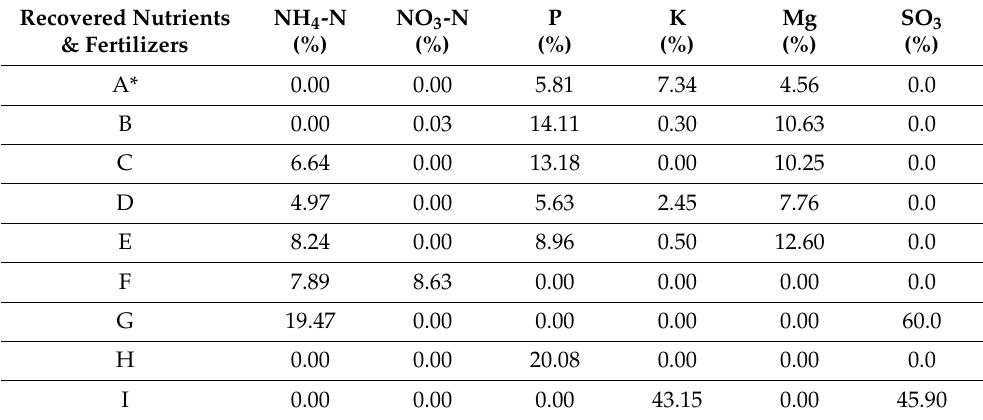
Table A1. Chemical composition of the different recovered nutrients.